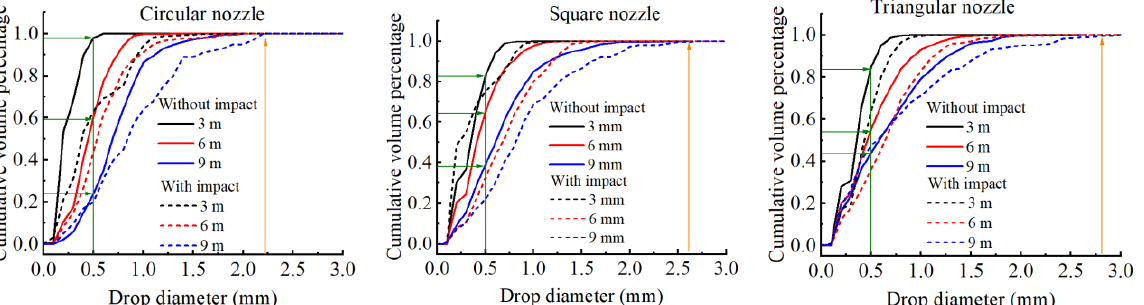
Figure 10. Comparison between the designed sprinkler and impact-driven sprinkler by the cumulative volume percentage of droplets under 200 kPa.